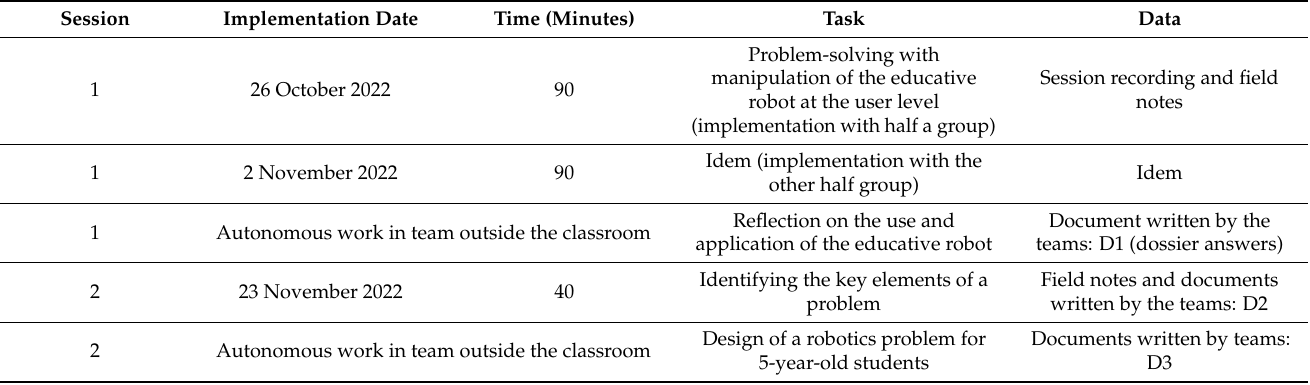
Table 2. Outline of the implemented didactic sequence.